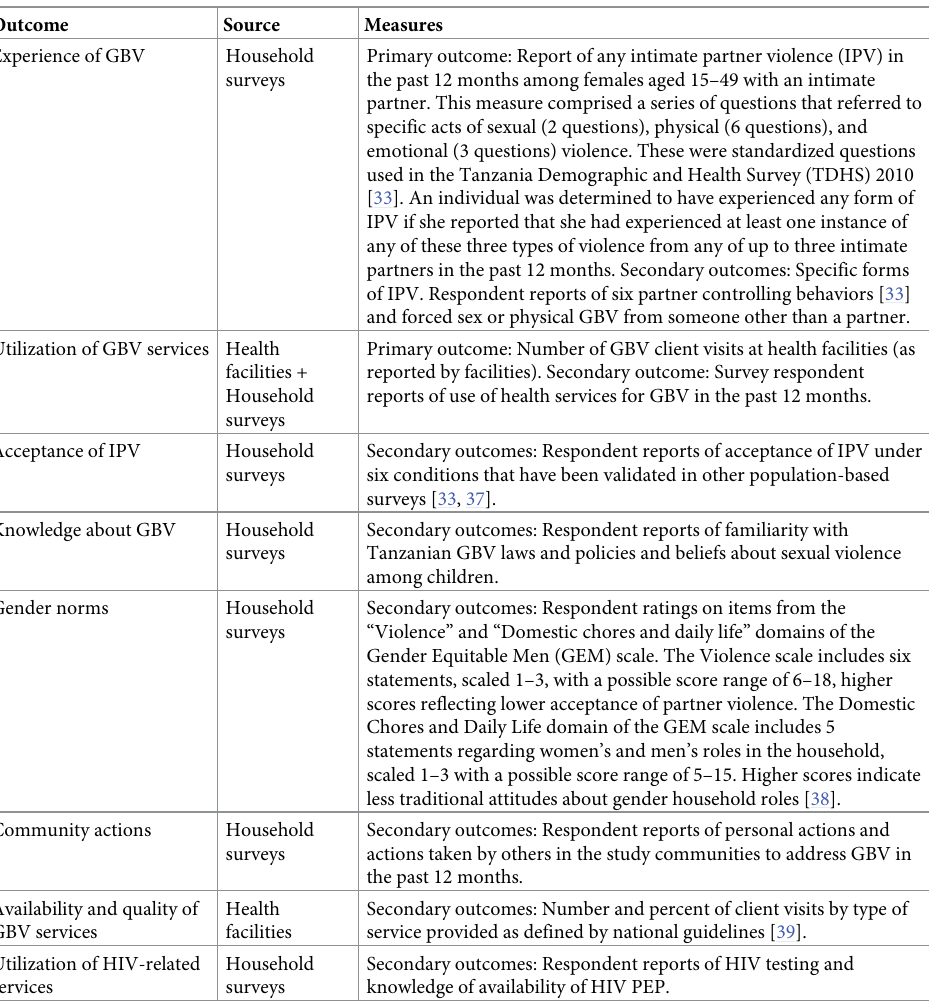
Table 2. Study outcome